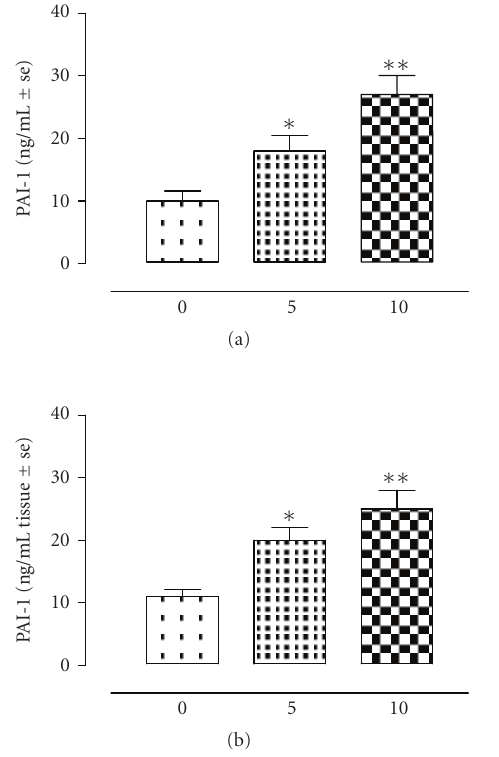
Figure 3: Plasma F1 + 2 and von Willebrand levels in rats ( n = 8) subjected to experimental peritoneal adhesion development. The time is expressed in days. Significant di ff erences from time 0 values are expressed as ∗ P < . 01; ∗∗ P < .